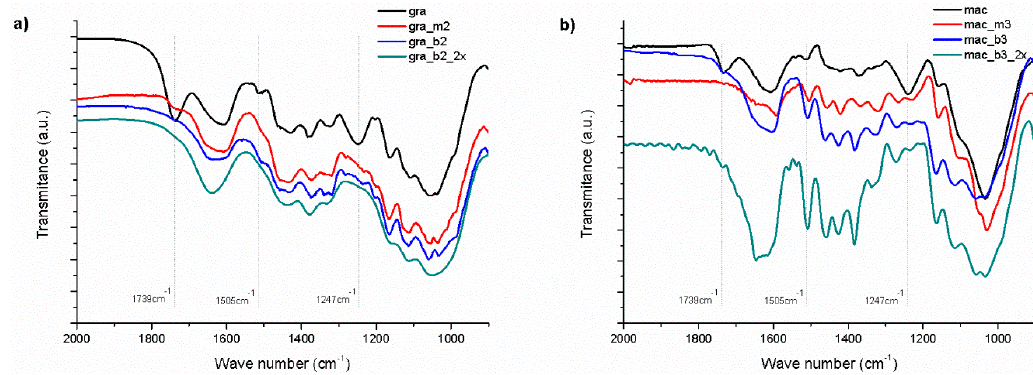
Figure 5. FTIR spectra of ( a ) gravata and ( b ) macauba: raw, mercerized and bleached fibers. In order to observe the fiber surfaces before and after the treatments, SEM analyzes were carried out and Figure 6 present SEM images for raw, mercerized and bleached fibers of gravata and macauba.